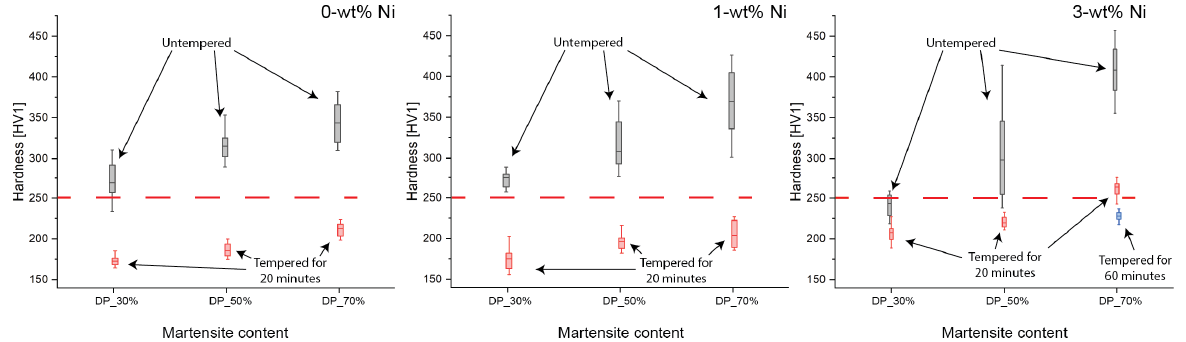
Figure 4. Hardness values for 0, 1, and 3-wt% Ni with DP_30%, DP_50%, and DP_70% in the as- quench and tempered condition plotted as black and red boxes, respectively. Tempered samples were heat treated at 550 °C for 20 min, and for 3-wt% Ni DP_70%, the tempering time was extended to 60 min (blue box) to meet the ASME B31.12 [3] and ISO 15156-2 [9] hardness limit, indicated as a red dash